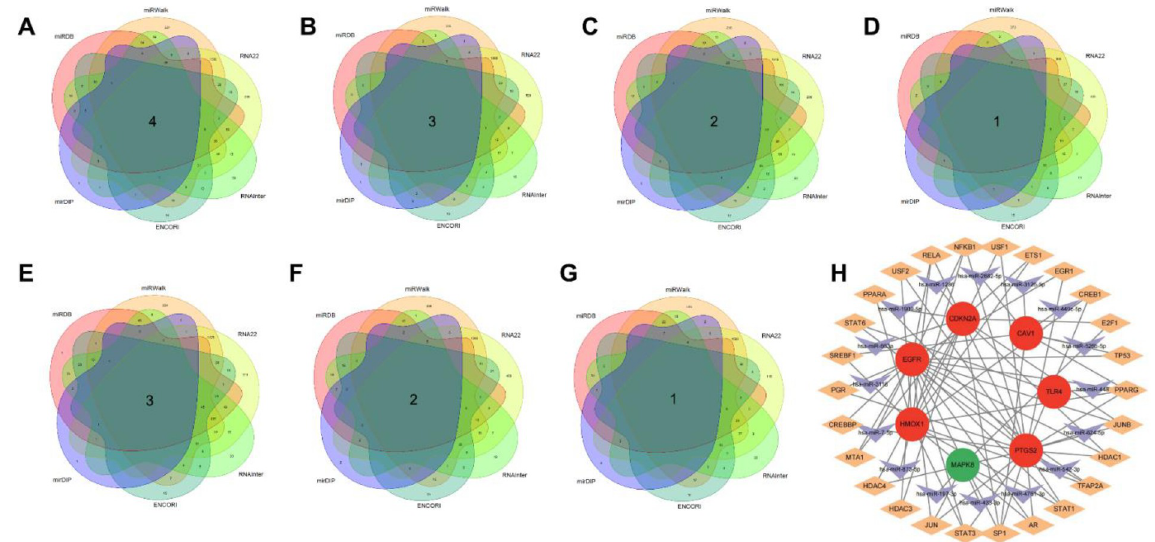
Fig 6. Network of miRNAs and TFs interacting with hub genes. (A-G) The number of miRNAs that CAV1, CDKN2A, EGFR, HMOX1, MAPK8, PTGS2 and TLR4 coexist in the five databases. (H) Network of miRNAs-genes-TFs interacting with hub genes. V shape represents miRNAs; Diamond represents TFs; Ellipse represents hub genes, red represents up-regulated genes, and green represents down-regulated gene.